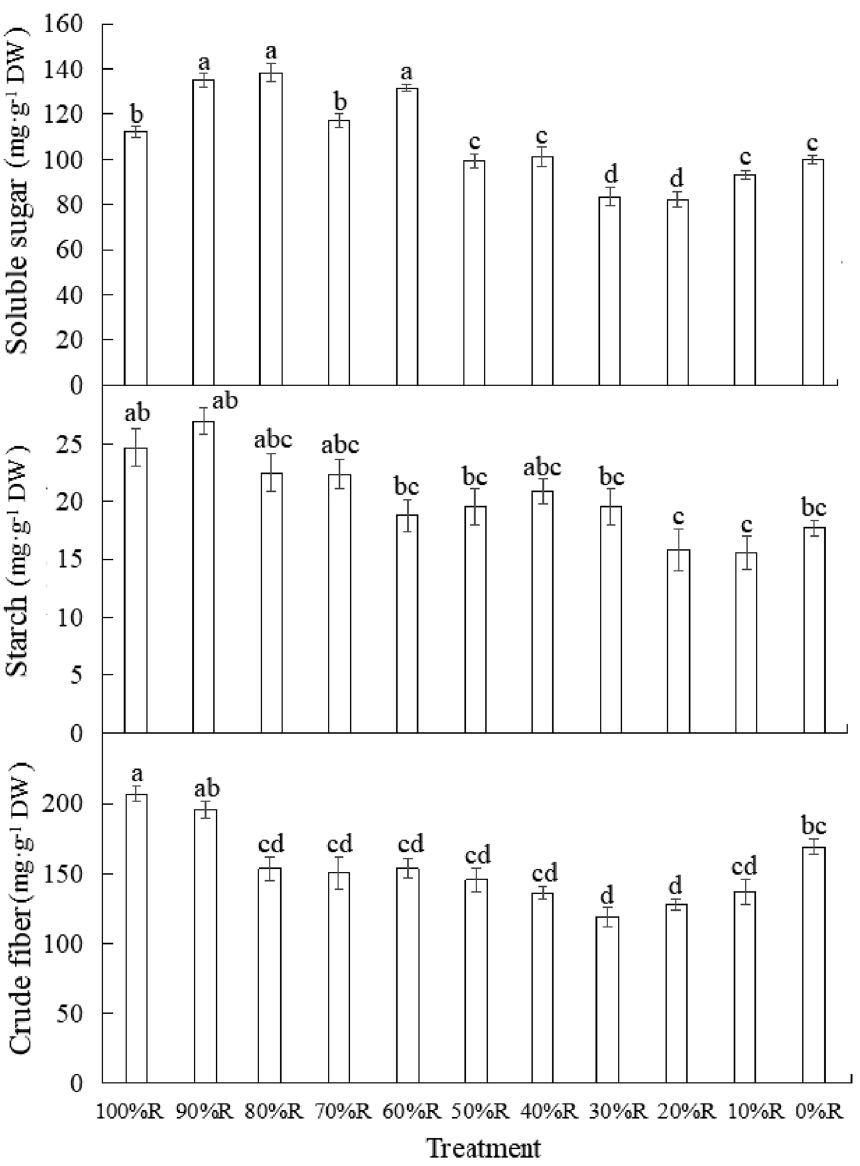
Figure 7. The contents of soluble sugar, starch and crude fiber of lettuce plants grown under different light treatments (at harvest). Different letters for the same parameter indicate significant differences at the 5% level, according to the Tukey’s test (n = 3). The bars represent the standard